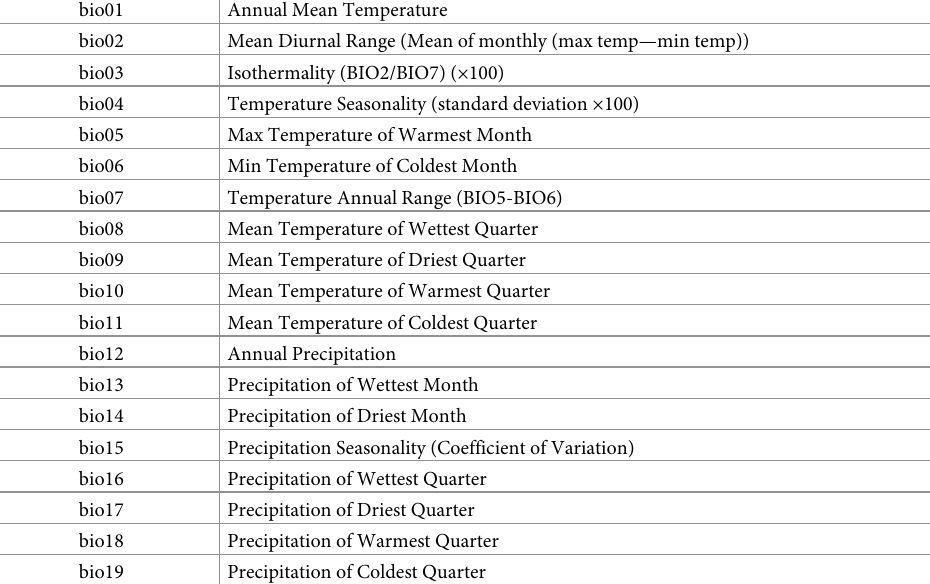
Table 1. Worldclim bioclimatic